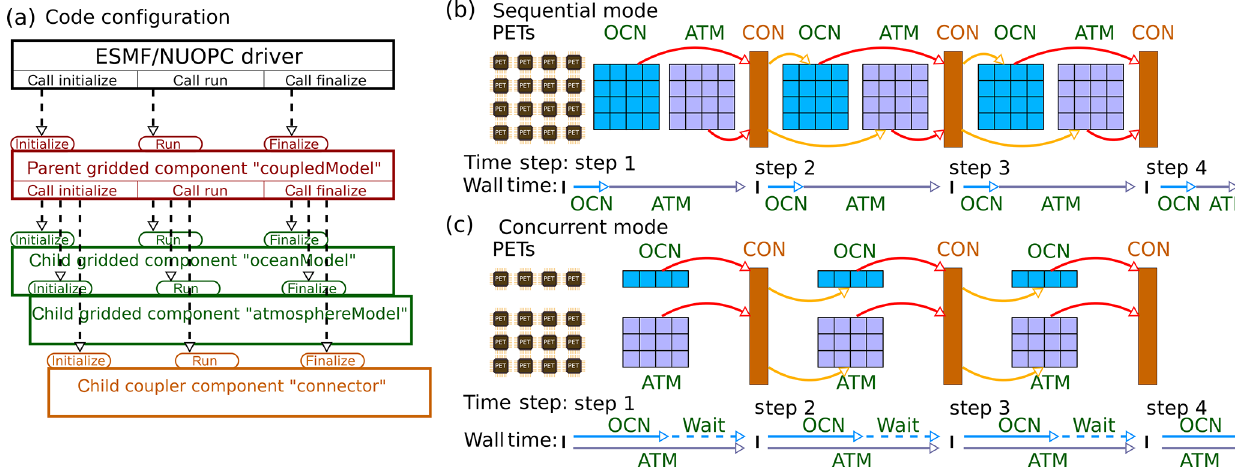
Figure 2. The general code structure and run sequence of the coupled ocean–atmosphere model. In panel (a) , the black block is the applica- tion driver ; the red block is the parent gridded component called by the application driver ; the green (brown) blocks are the child gridded (coupler) components called by the parent gridded component . Panels (b) and (c) show the sequential and concurrent mode implemented in SKRIPS, respectively. PETs (persistent execution threads) are single processing units (e.g., CPU or GPU cores) defined by ESMF. Abbrevi- ations OCN, ATM, and CON denote oceanic component, atmospheric component, and connector component, respectively. The blocks under PETs are the CPU cores in the simulation; the small blocks under OCN or ATM are the small subdomains in each core; the block under CON is the coupler. The red arrows indicate that the model components are sending data to the connector and the yellow arrows indicate that the model components are reading data from the connector. The horizontal arrows indicate the time axis of each component and the ticks on the time axis indicate the coupling time